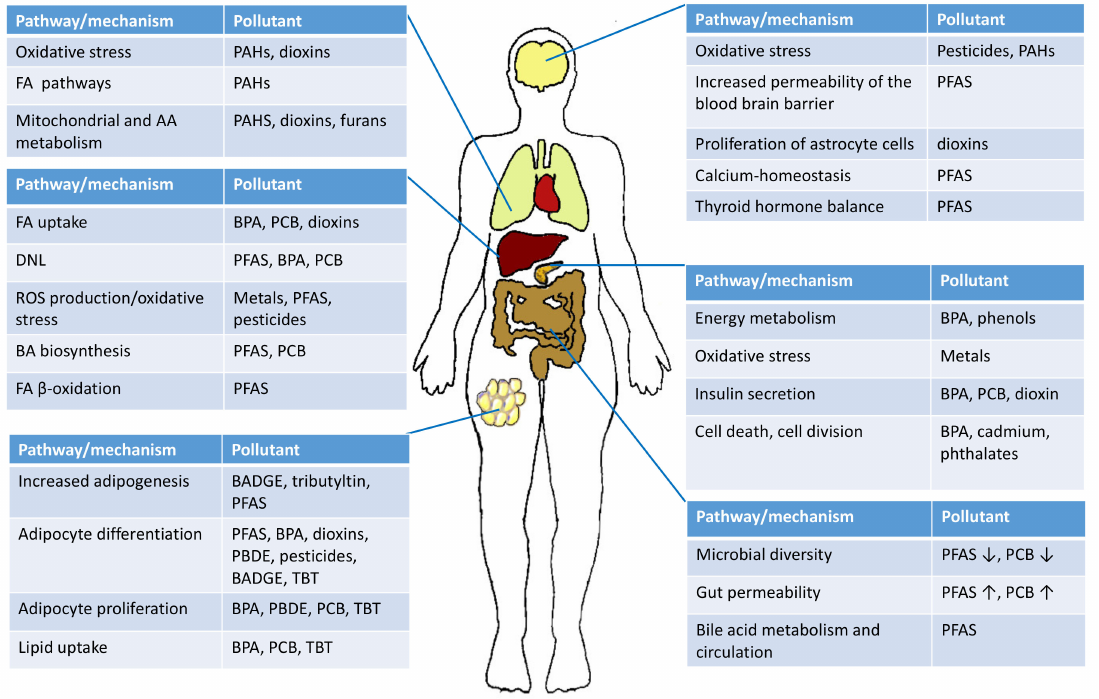
Figure 2. Reported impacts of exposure to environmental chemicals on